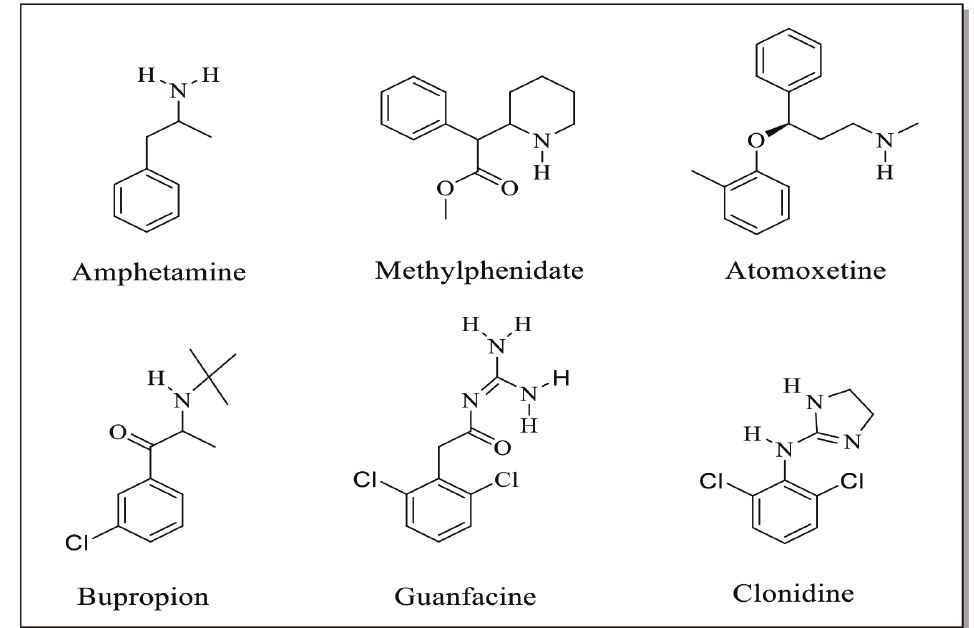
Figure 1: Structures of ADHD